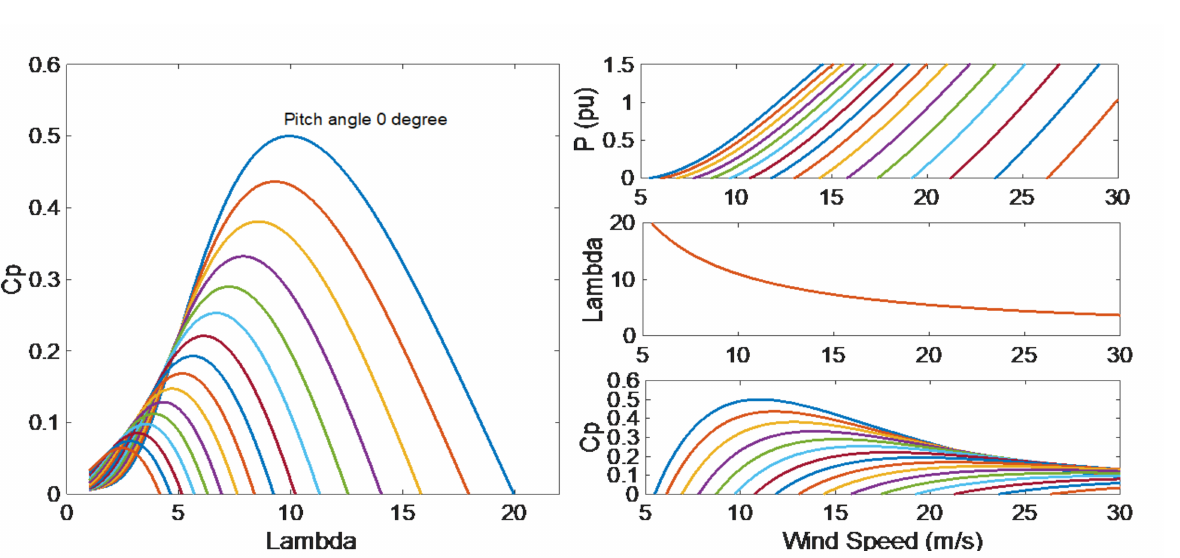
Figure 7. Wind turbine characteristic